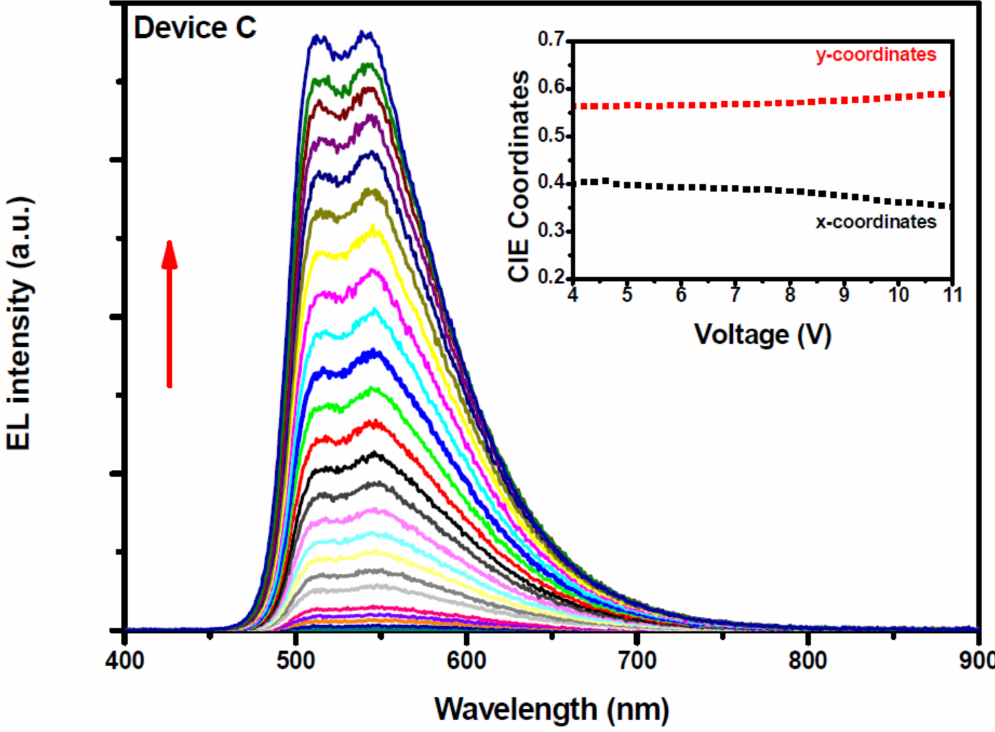
Figure 5. Electroluminescence spectra of OLEDs with device configuration C recorded by varying the applied voltage. Inset: variation of the dominant wavelength with the driving voltage and CIE coordinates of the emitted